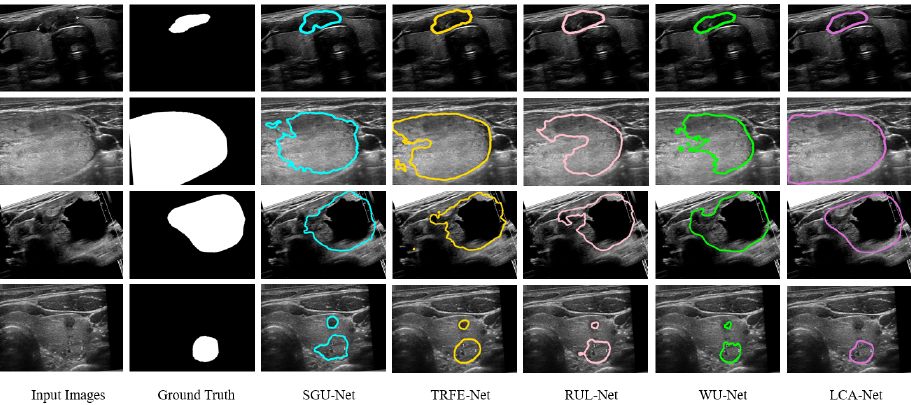
Figure 7. Qualitative comparison of different models on the TN-SCUI2020 dataset. Our predictions are closest to the ground truth and keep finer information.